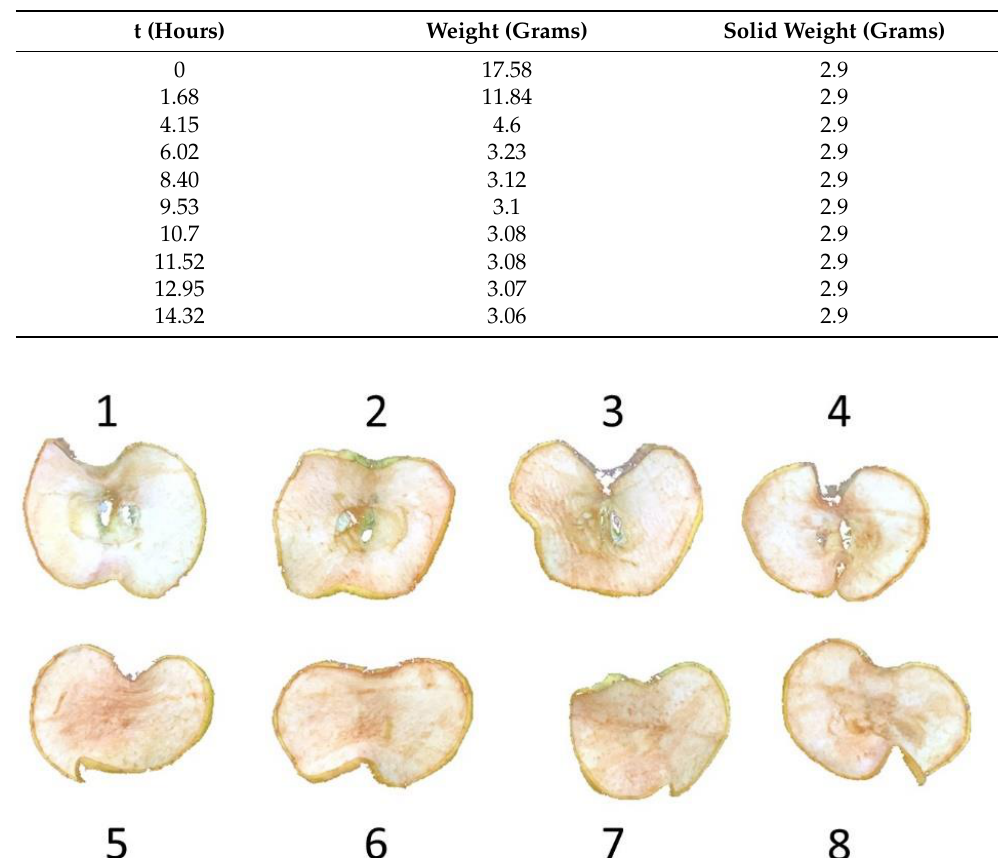
Figure 6. Number assigned to each apple slice. The assignation was based on its position in the oven.